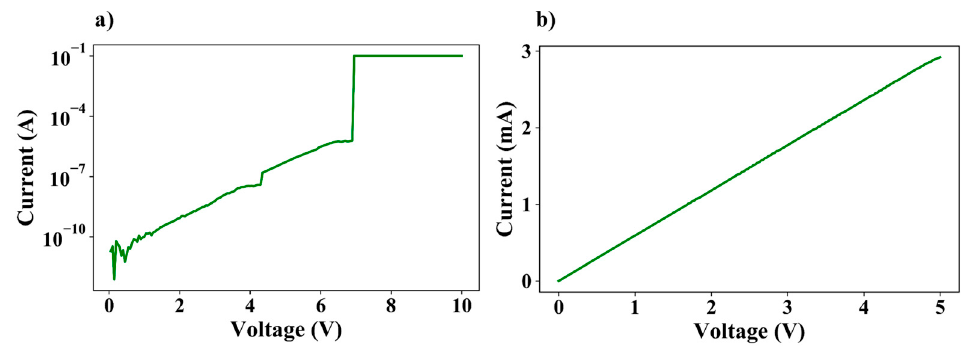
Figure 12. ( a ) Instantaneous breakdown of the dielectric film at ~7 V demonstrated by a sudden increase in conduction current. ( b ) I–V plot of the device after dielectric breakdown typical of ohmic conduction.